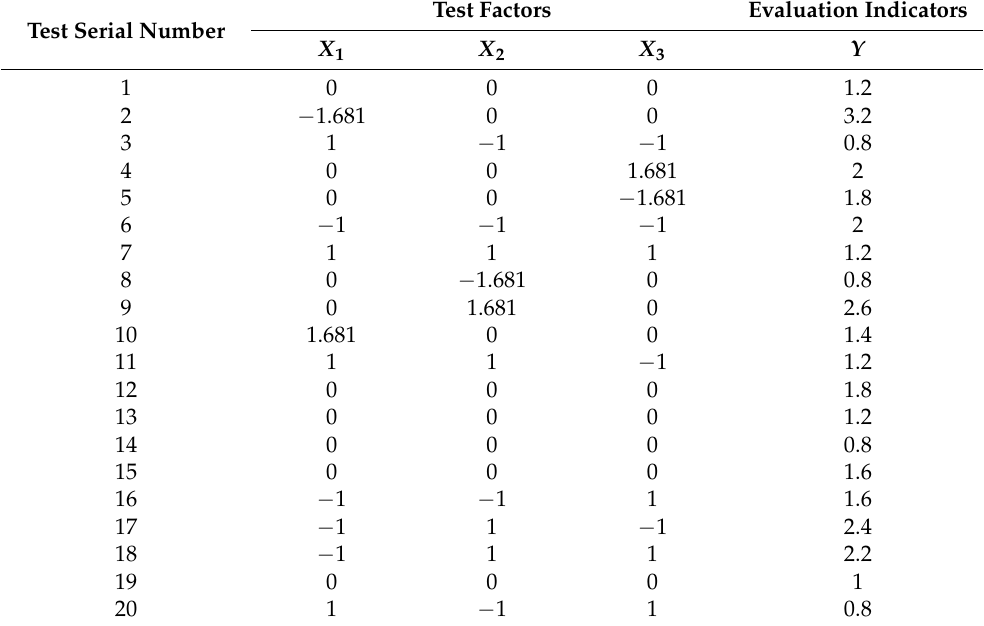
Table 3. Bench test results.